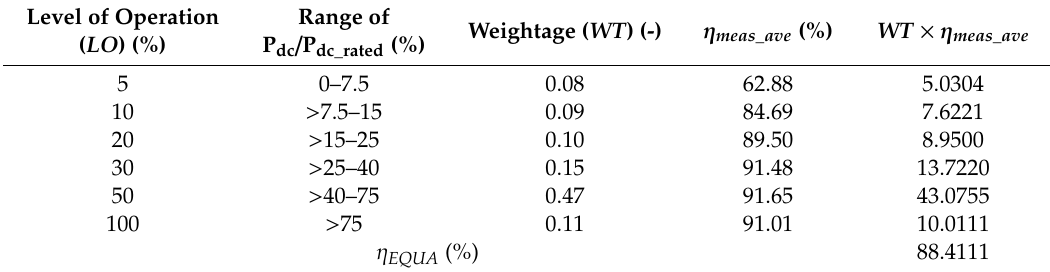
Weighted e ffi ciency for the SB700LF inverter when G = Gi and T = 25 ◦ C